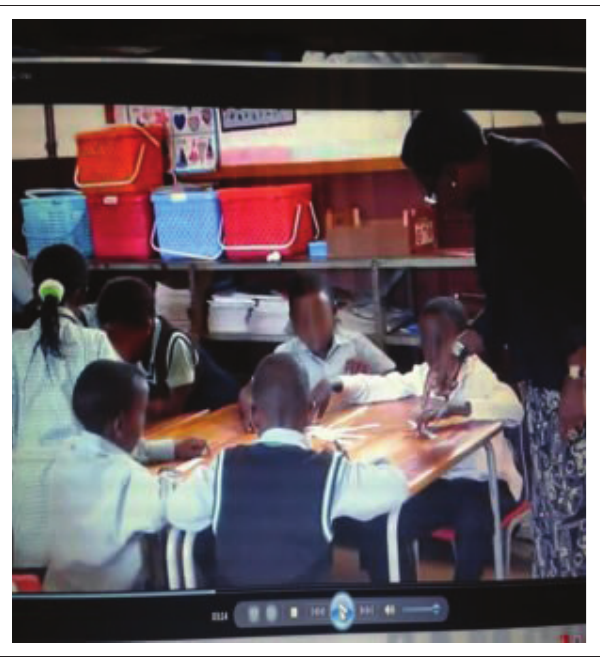
FIGURE 18: Supervision of idiom